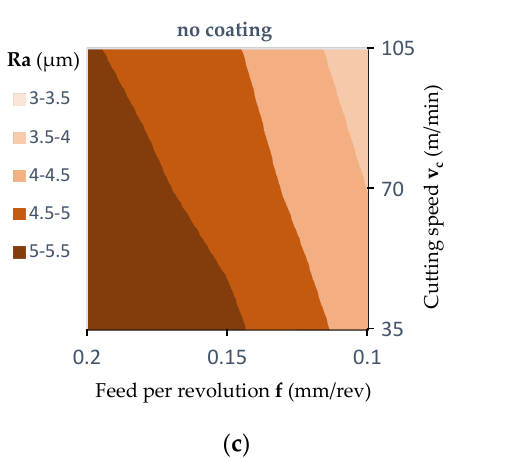
Table 7. Significance level of the effect of cutting parameters on the roughness average (Ra). 407